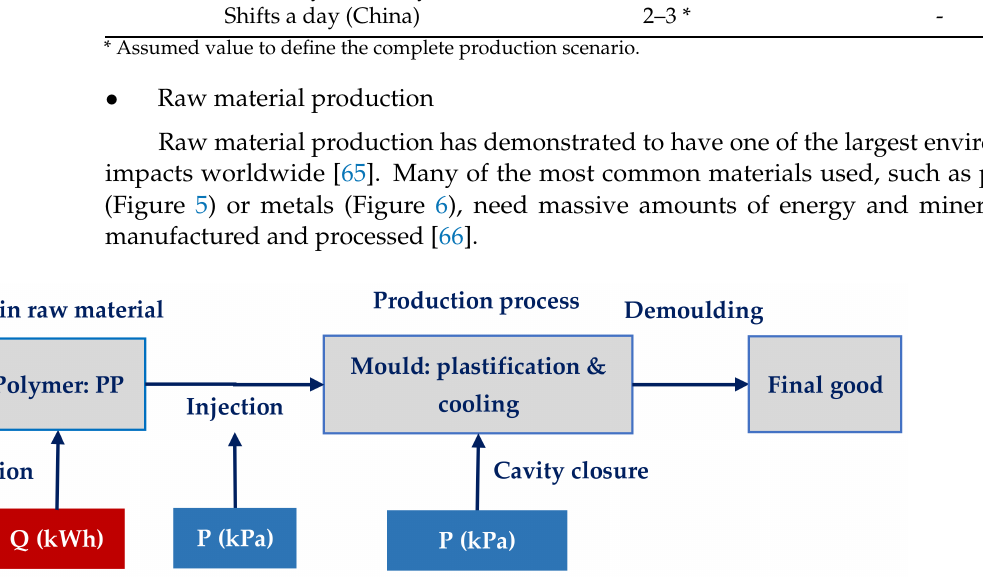
Figure 5. Polymer production process [57]. Necessary for protecting the product during transport (Table 15).